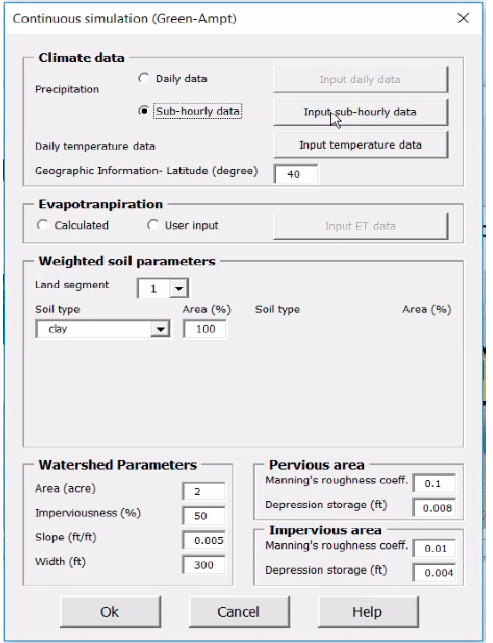
Figure A5. Input parameters for Green-Ampt model